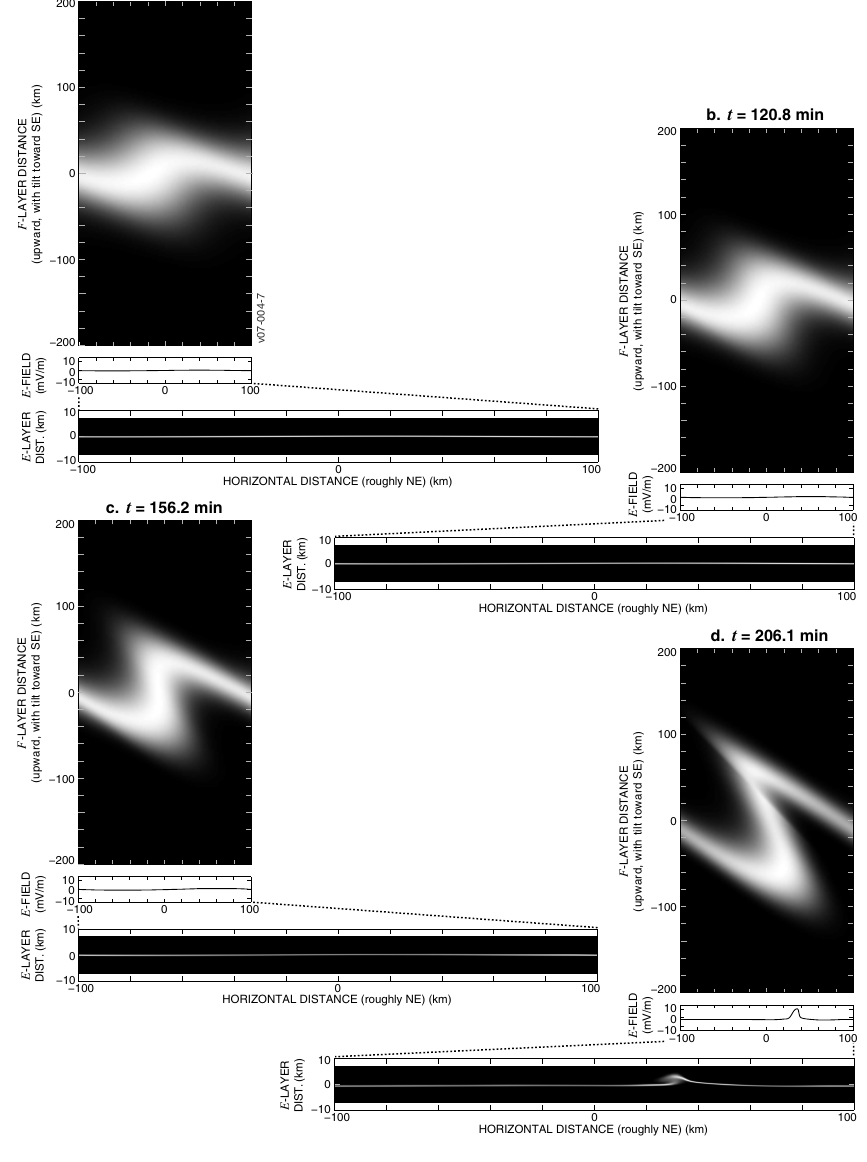
Figure 5: Coupled system evolution under non-resonant condition, with Σ H Σ The boundaryconditions are periodic in the horizontal direction. The axes are described in thefirst paragraphs of Section 4, and summarized in Figure 3. Fig. 5. Coupled system evolution under non-resonant condition, with 6 H